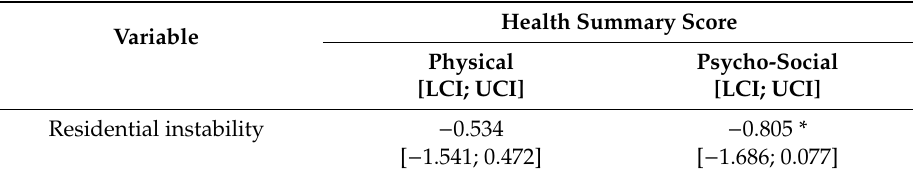
Analytical results: Table 2 summarizes the results for the fixed-e ff ects regression models. Notably, both e ff ect sizes are almost uniformly small (but negative). Confidence intervals, however, suggest no statistical significance for the physical, and moderate significance for the psycho-social summary measure (at a 10% significance level). Table 2. Summary of fixed e ff ect